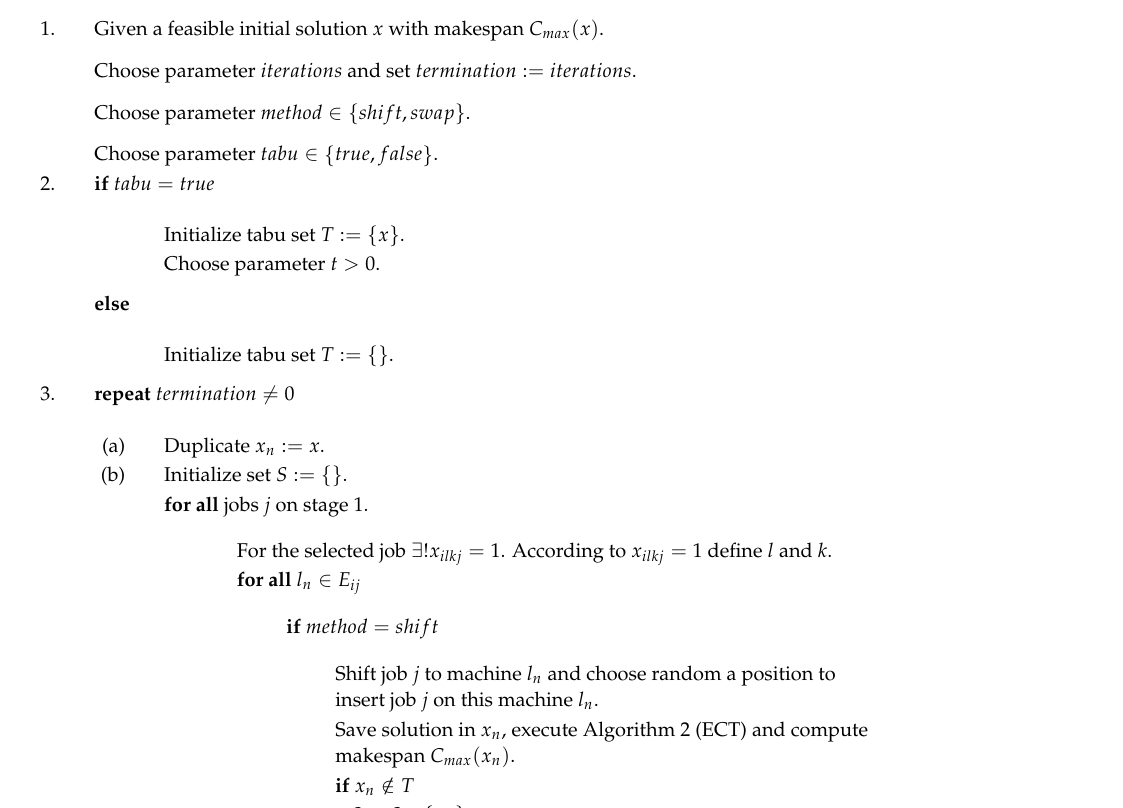
Algorithm 4: Tabu and Local Search—Steepest